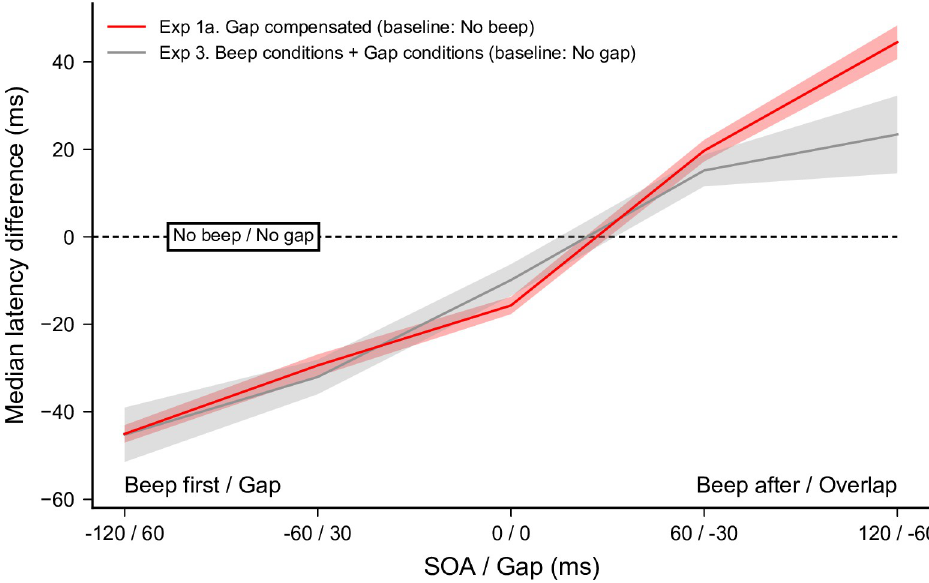
Fig 9. Experiment 3. Testing linear combination of beep MSI modulation and gap/overlap on saccade latency. Comparison of the Gap compensated condition from Experiment 1a for the same participants, with the combination of the Beep conditions and Gap conditions from Experiment 3, using the same baseline condition (respectively No beep and No gap ).